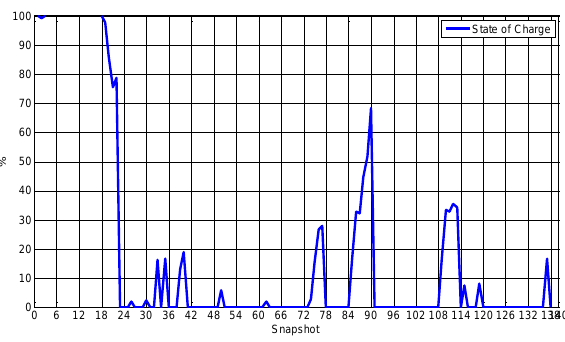
Fig.6. Test system. Low data redundancy (